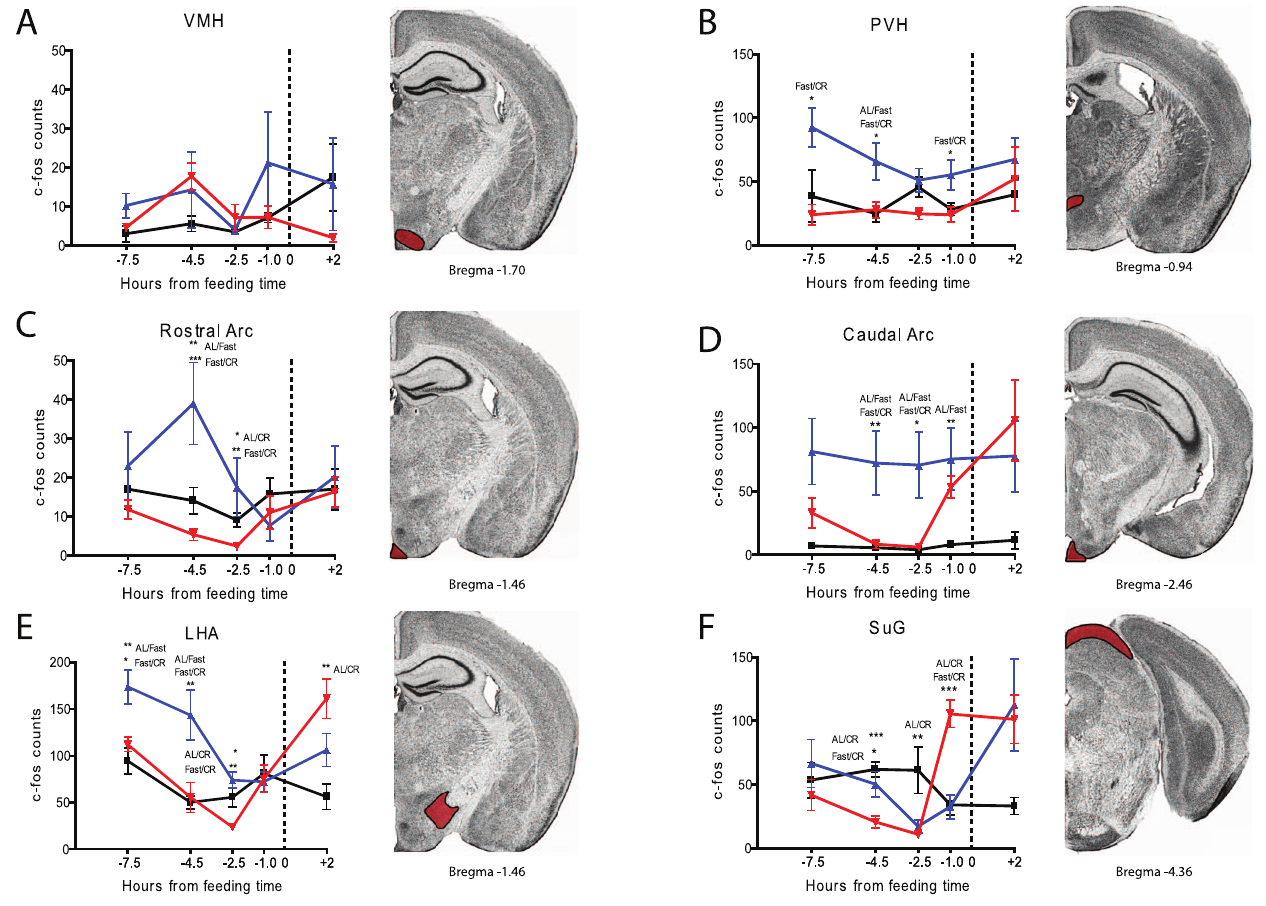
Figure 5. c-Fos induction in VMH, PVH, LHA, Rostral and Caudal Arc, and SuG of calorie-restricted, acutely fasted, and AL control mice. Mean ( 6 SEM) number of c-Fos-immunoreactive nuclei in the several brain nuclei of AL controls (blue), fasted (blue), and CR (red) at 5 time points relative to feeding. TP 0 represents time of expected meal presentation as highlighted by the vertical dotted line on the x-axis. (A) Mean ( + / 2 SEM) c-fos counts for the ventral medial hypothalamus (VMH). (B) c-Fos counts for the paraventricular nucleus (PVH). (C) c-fos counts for the rostral arcuate nucleus. (D) c-fos counts for the caudal arcuate nucleus. (E) c-fos counts for the lateral hypothalamus (LHA). (F) c-fos counts for the superior colliculus gray layer (SuG). Sample sizes for TP 2 7.5 thru + 2 are n=2–6, 7–12, 7–12, 6–9, 4–6 for AL groups, n=3–6, 4–12, 5–12, 4–9 for CR groups, and n=5–6, 5–6, 2–6, 6, 5–6 for Fast groups. Representative images of each neuroanatomical location are shown (from Paxinos and Franklin).